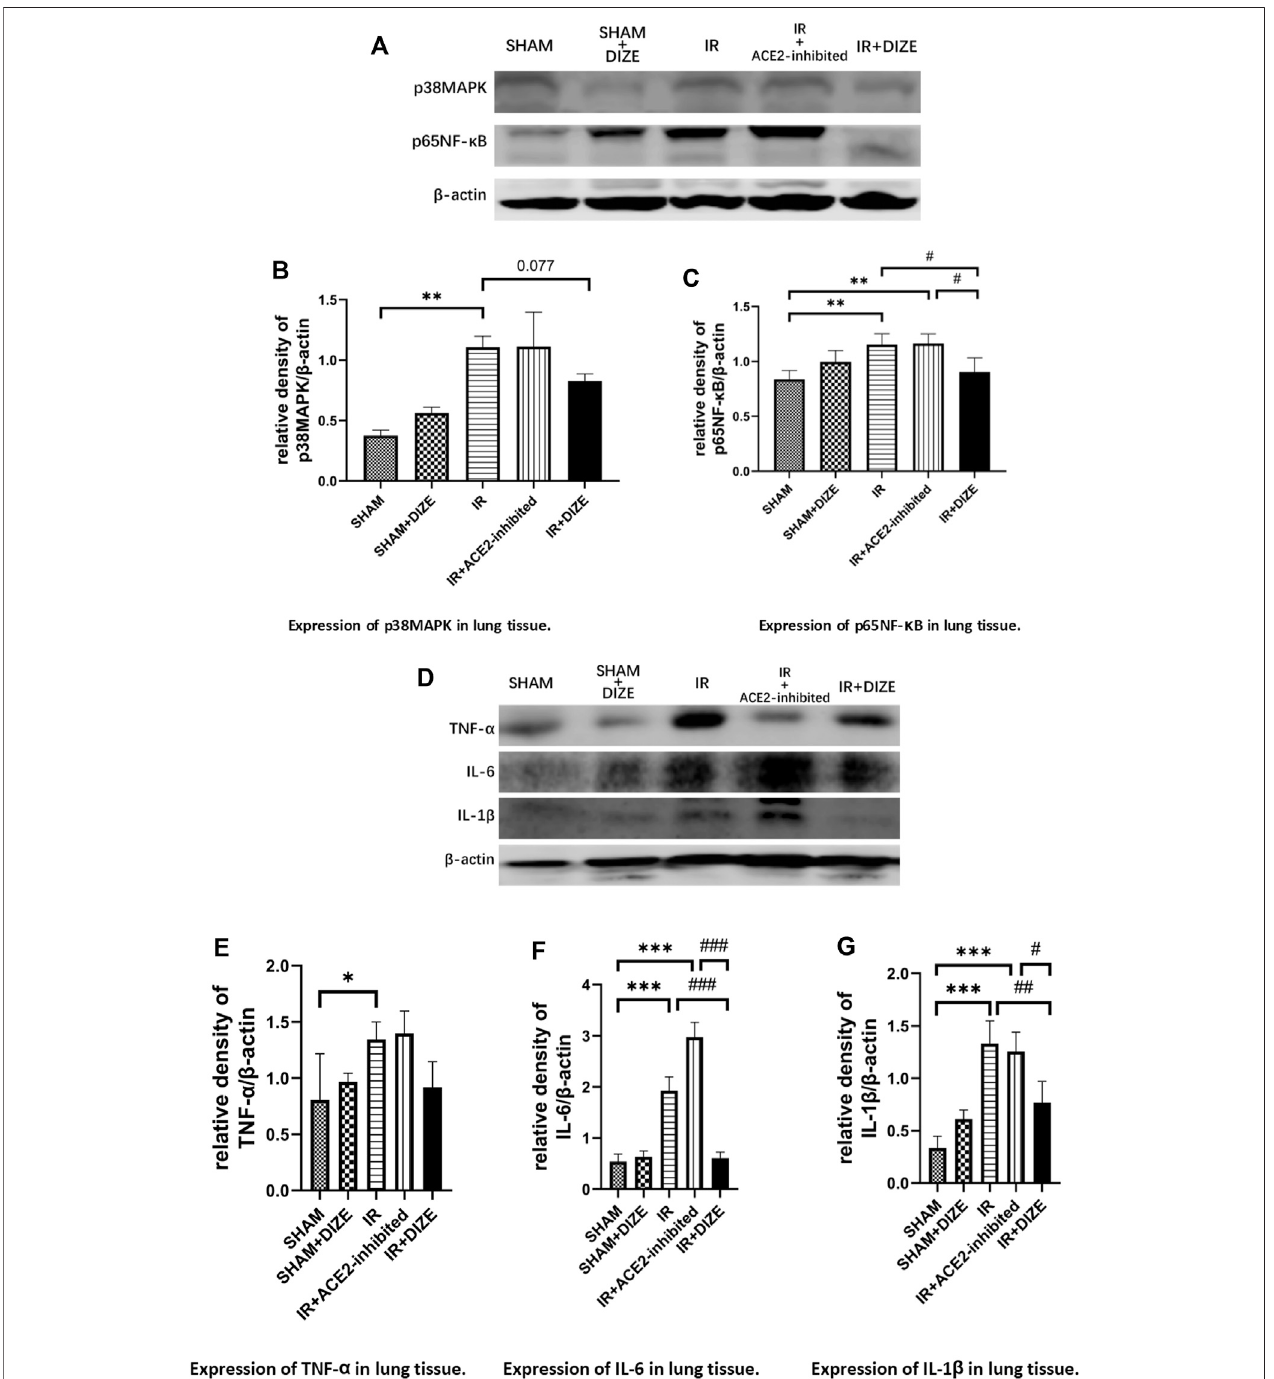
FIGURE7| DIZEcouldsigni fi cantlylowerin fl ammatorymarkersIL-6andIL-1 β duringtheearlystageoflungIRinjury. (A) Westernblotanalysisofp38MAPK-NF- κ B signaling pathway in rat lung. (B) Expression of p38MAPK in lung tissue (post-hoc analysis: Dunnett ’ s T3 test). (C) Expression of p65NF- κ B in lung tissue (post-hoc analysis:Tukey ’ stest). (D) Westernblotanalysisofpro-in fl ammatorycytokinesintheratlung. (E) ExpressionofTNF- α inlungtissue(post-hocanalysis:Tukey ’ stest). (F) Expression of IL-6 in lung tissue (post-hoc analysis: Tukey ’ s test). (G) Expression of IL-1 β in lung tissue (post-hoc analysis: Tukey ’ s test). Data were expressed as mean ± SEM ( n (cid:1) 7), *p < 0.05, **p < 0.01, ***p < 0.001 vs. SHAM group ; # p < 0.05, ## p < 0.01, # ## p < 0.001 vs. IR group .